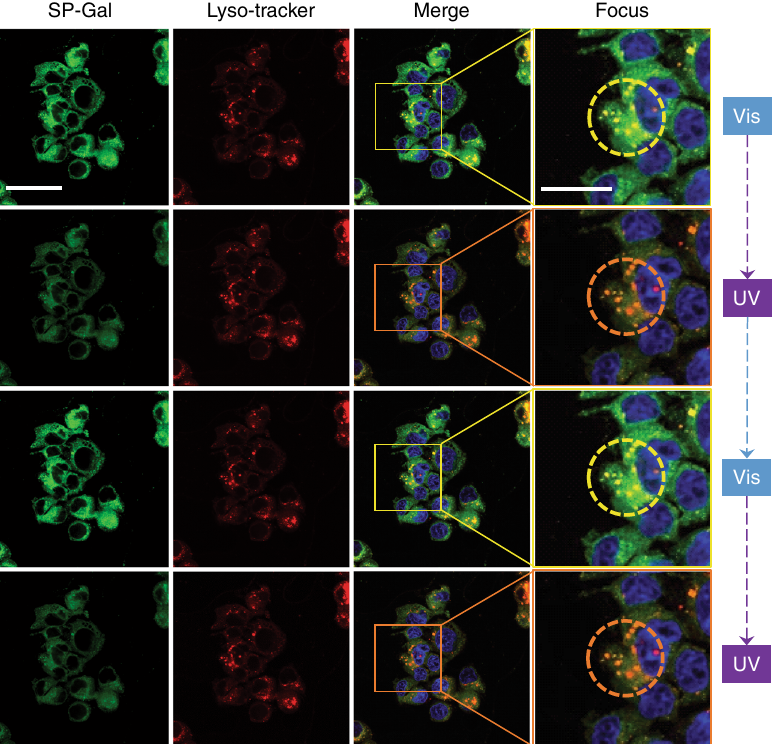
Fig. 4 UV/Vis cycling and co-localization of photochromic glycoprobes with lysosome tracker in Hep-G2 cells. The excitation wavelength was 405, 440, and 577 nm and emission channel 420 – 460, 535, and 590 nm for Hoechst, SP-Gal and Lyso-tracker Red, respectively (the “ Focus ” column represents an enlarged area of the “ Merge ” column as framed; the circles in the “ Focus ” column highlight the photochromic actions of SP-Gal in lysosomes). Scale bar for all images in the Sp-Gal, Lyso-tracker and Merge groups is 40 μ m. Scale bar for images in the “ Focus ” group is 20 μ m